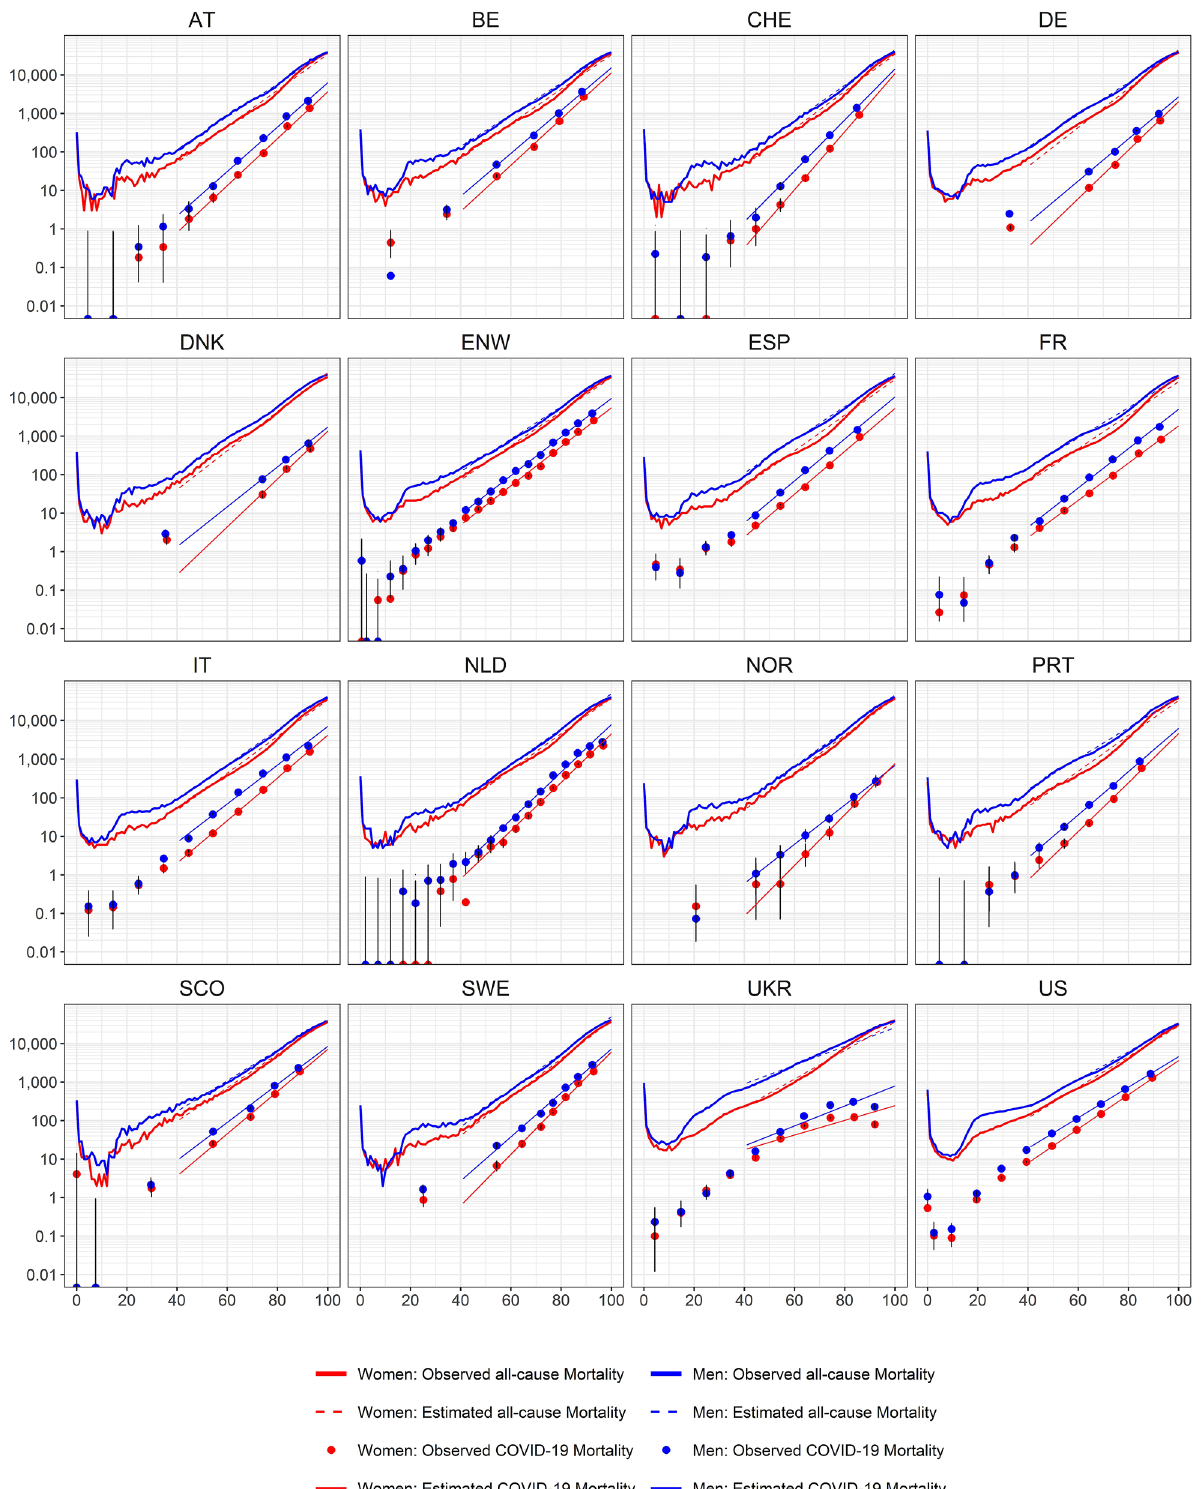
Figure 2. Age- and sex-specific all-cause and COVID-19 deaths in 16 countries. Predictions of Model 1 (see text) are given by straight lines on a log scale (dashed lines all-cause mortality, solid lines COVID-19 mortality). The curves show the number of persons who normally die per 100,000 within the next year depending on age and sex taken from all-cause mortality life tables per country before 2020 (red curves women; blue curves men). The dots are the number of COVID-19 deaths per 100,000 plotted at the means of age in the respective age categories. The vertical lines represent 95% confidence intervals with lower bounds cut at 0.001. The fitted model estimates for COVID-19 mortality in over 40 years old and all-cause mortality are shown by the solid and dashed lines from 40 years old and over. Country codes are defined in Table